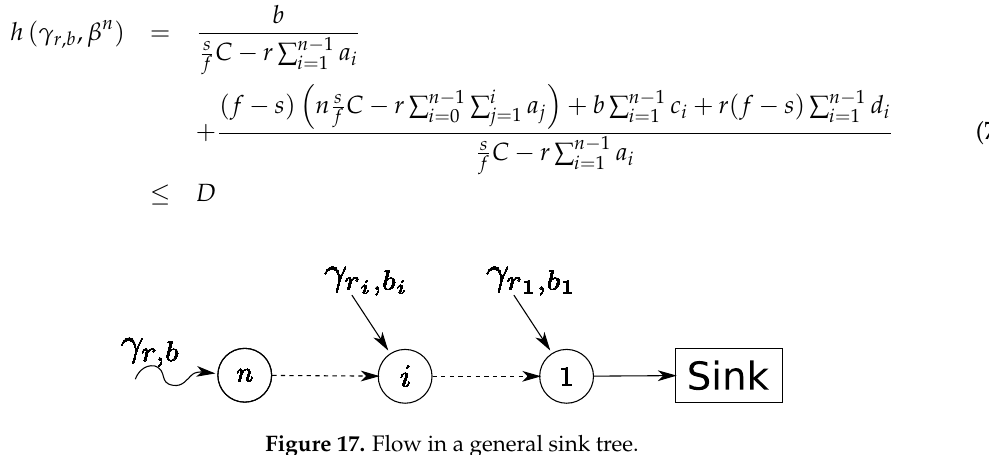
Figure 17. Flow in a general sink